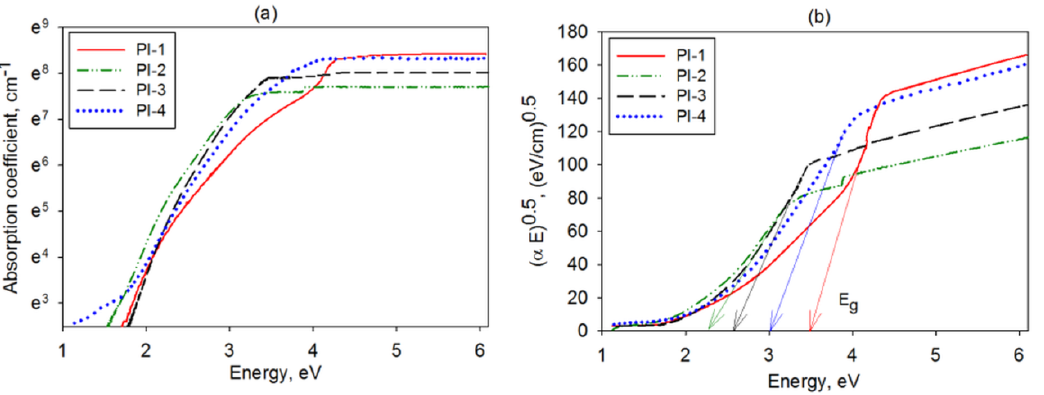
Figure 3. ( a ) The absorption coefficient variation with energy and ( b ) Tauc plot for the PI-1, PI-2, PI- 3, and PI-4